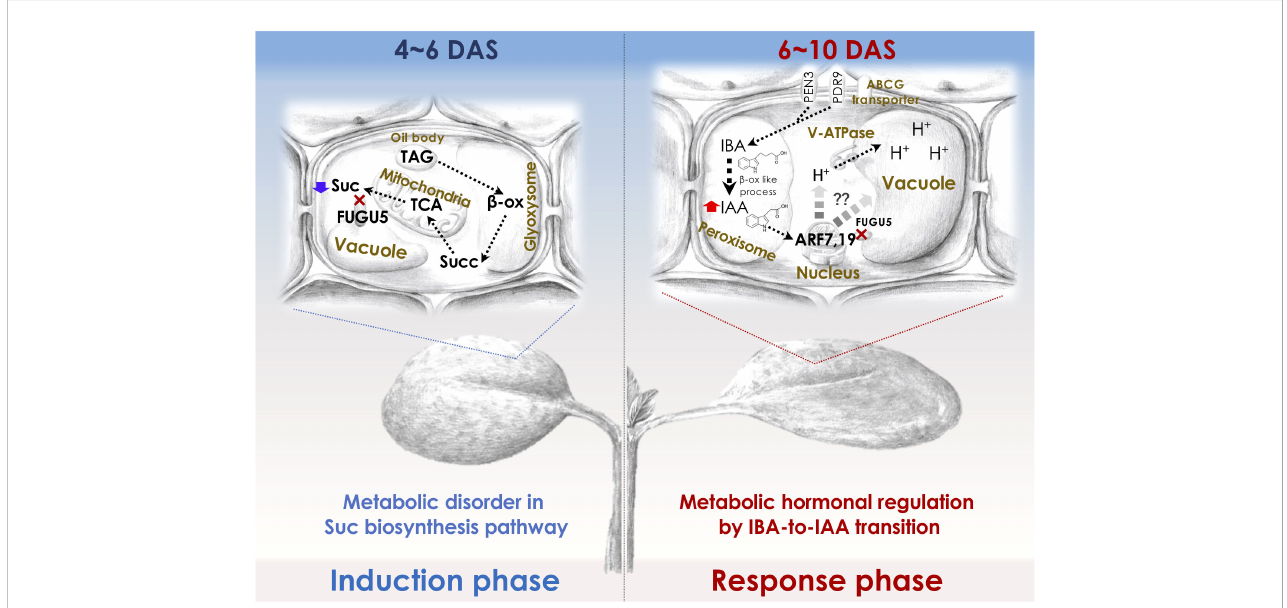
FIGURE 2 Molecular machinery of the induction and response phases in class II CCE. The decreased cell number (induction phase) in Arabidopsis fugu5 -mutant cotyledons has been shown to be exclusively due to a decreased level of TAG-derived Suc, and IBA-derived IAA (Katano et al., 2016; Takahashi et al., 2017) has been suggested to mediate CCE (response phase) as follows: First, upon seed imbibition, excess cytosolic PPi in fugu5 leads to the inhibition of de novo Suc synthesis from TAG, a major seed-storage lipid and substrate for the conversion of fatty acids to acetyl-CoA for glyoxylate bypass that takes place in the glyoxysome (Ferjani et al., 2011). This is owing to inhibition of gluconeogenesis (Ferjani et al., 2018). Second, during seedling establishment, metabolic disorder associated with the reduced Suc content (4-6 DAS; left panel) is converted into an ‘ output instructive signal ’ (6-10 DAS; right panel) that promotes the conversion of IBA, an auxin precursor, to IAA, the natural phytohormone auxin, leading to an increase in endogenous IAA concentration, which is crucial for CCE (Tabeta et al., 2021). Third, increased endogenous IAA (IAA concentration peaks at 8-10 DAS) triggers the TIR/ AFB-dependent auxin signaling pathway through the AUXIN RESPONSE FACTORs ARF7 and ARF19, transcriptional activators of early auxin-response genes. This subsequently activates the vacuolar type V-ATPase, leading to an increase in turgor pressure, which ultimately drives an increase in cell size and CCE (Tabeta et al., 2021; Nakayama et al., 2022). b -ox, b -oxidation; Succ, succinate. Glyoxysome, the single membrane-bound organelles that house most of the biochemical machinery required to convert fatty acids derived from TAG to 4-carbon compounds. TCA, the tricarboxylic acid cycle.